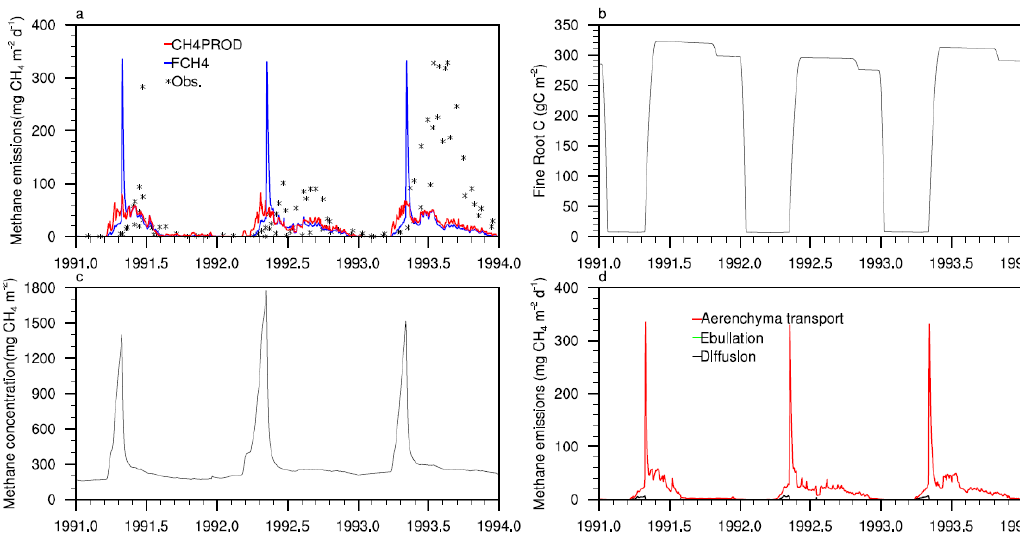
Fig. B. Model simulations at the Michigan site (Shannon and White, 1994). (a) Model simulated 2" Fig. B1. Model simulations at the Michigan site (Shannon and White, 1994). (a) Model-simulated emission rates and production rates vs. observations; (b) model-simulated fine root carbon; (c) vertially averaged methane concentration in the model; (d) partition of methane emission rates and production rates vs. observations; (b) model simulated fine root carbon; (c) 3" fluxes through aerenchyma transport (red), ebullition (green), and surface diffusion (black). vertially averged methane concentration in the model; (d) partition of methane fluxes through 4" aerenchyma transport (red), ebullition(green), and surface diffusion(black). 5"